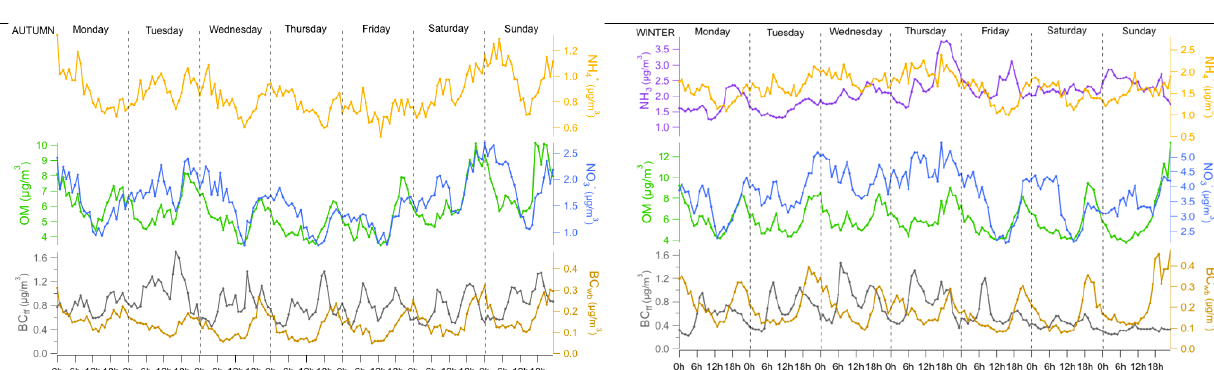
Figure 10. Seasonal weekly diurnal variations of OM (green), NO − (brown).